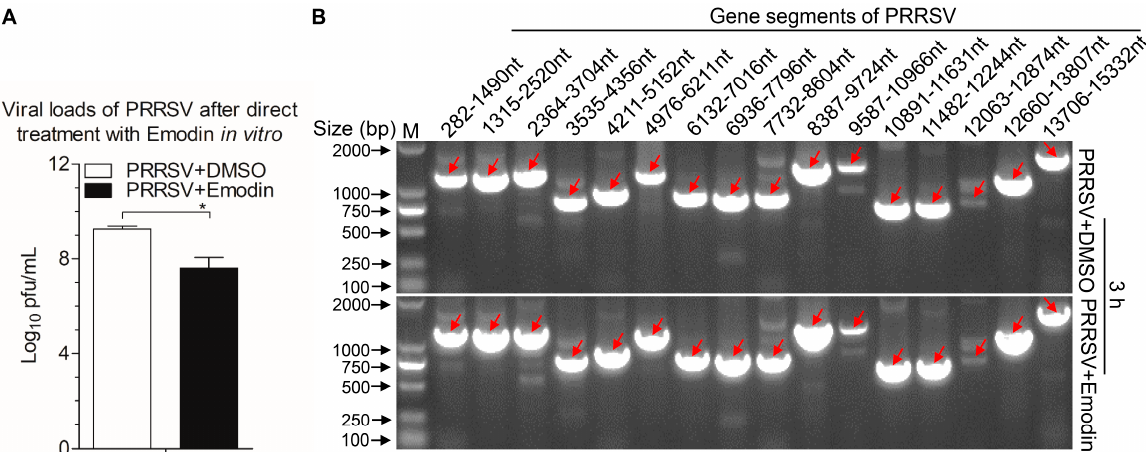
Figure 5. Emodin inactivated PRRSV directly but did not degrade the viral genome. PRRSV exposed to Emodin at the indicated concentration (6.25 µ g/mL) at 37 ◦ C for 3 h, then virus yields were titrated by TCID 50 in Marc-145 cells ( A ), the whole genome sequences of the PRRSV after Emodin or 0.1% DMSO treatment were amplified by RT-PCR ( B ). Data are representative of three independent experiments (mean ± SD). n = 3. * p < 0.05.